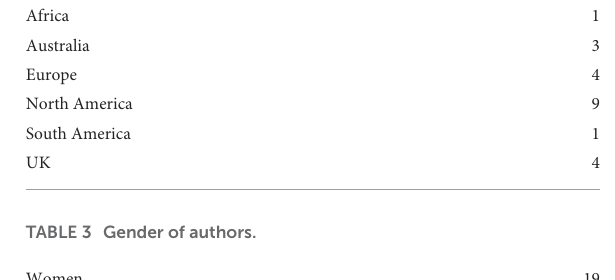
TABLE 3 Gender of authors.